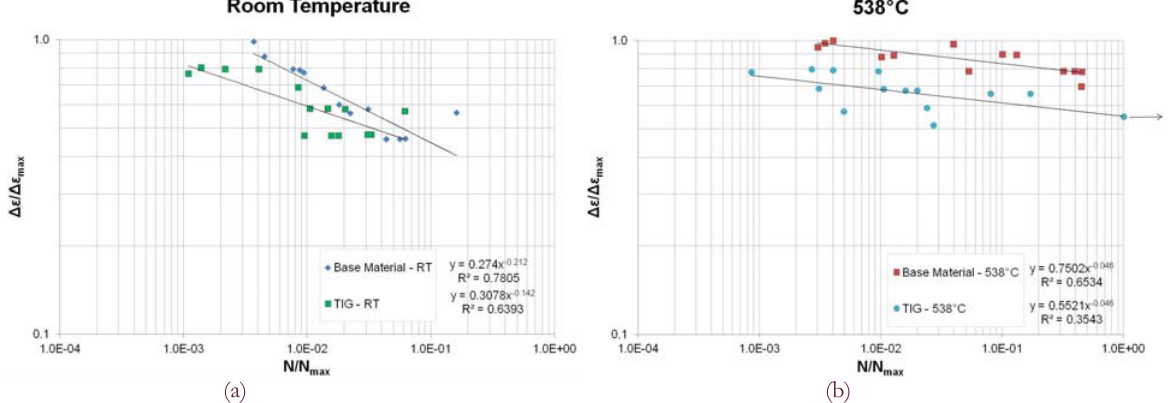
Figure 7: Comparison of fatigue curves in terms of applied strain range at RT (a) and 538°C (b).